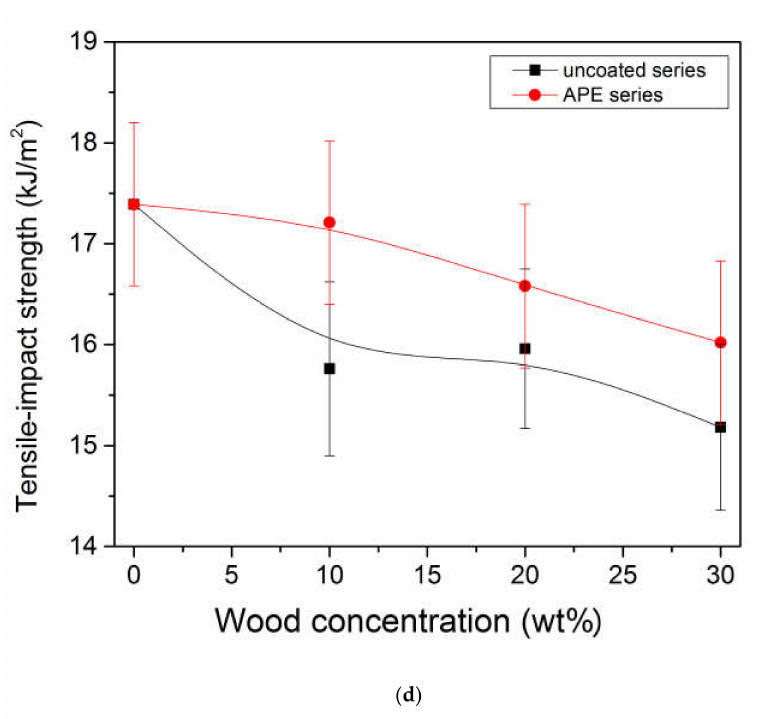
Figure 7. E ff ect of wood concentration and filler treatment on sti ff ness ( a ), tensile strength ( b ), elongation at break ( c ), and tensile impact strength ( d ) of PLLA / wood composites. Symbols: PLLA / wood ( (cid:4) ) and PLLA / wood / APE ( •